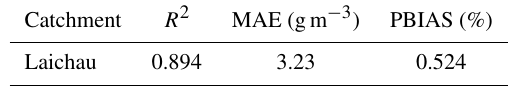
Table 5. Performance of sediment simulation model for Laichau. Catchment